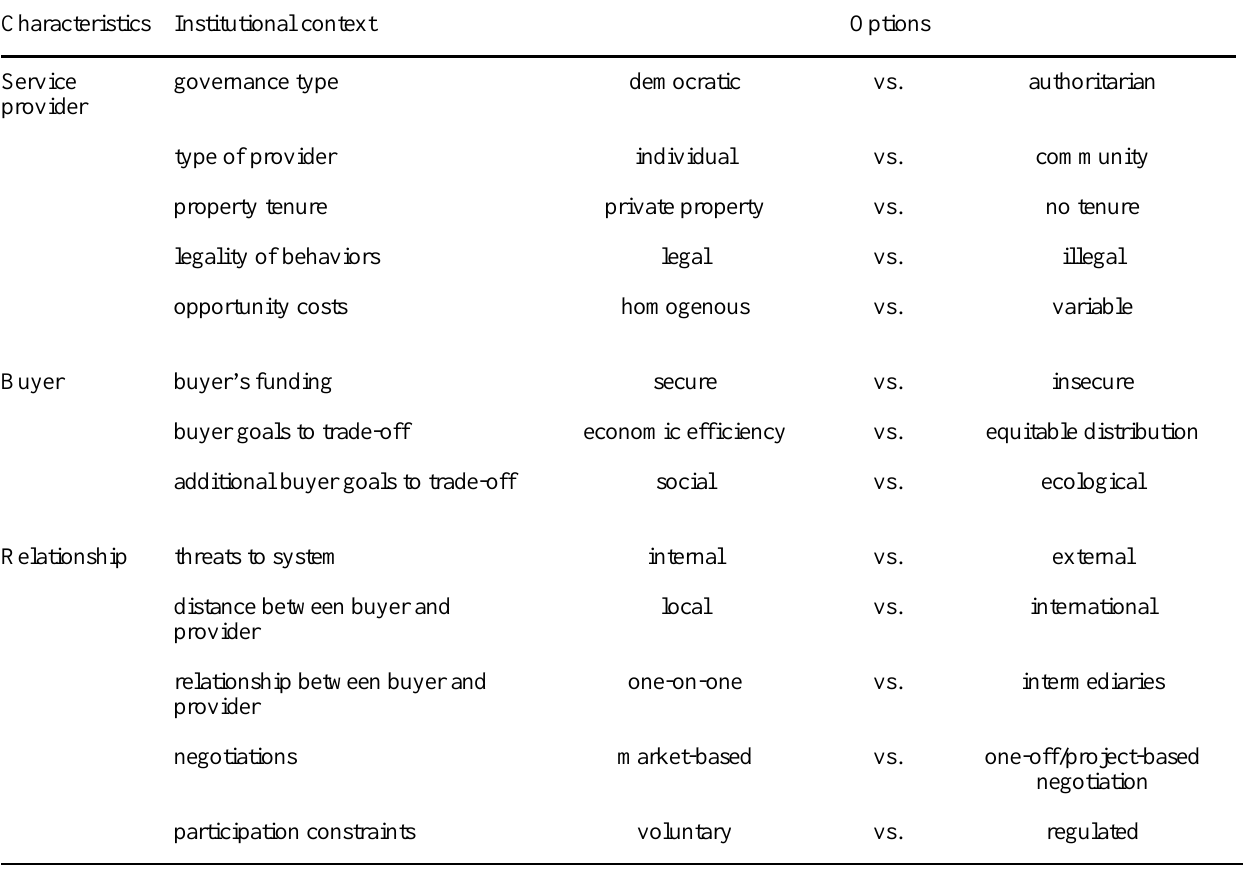
Table 2. Nonexhaustive list of institutional contexts under which PES may be implemented. Characteristics on the left side of the options are generally (although not always) easier contexts for implementing PES. These choices often rest within a continuum rather than a